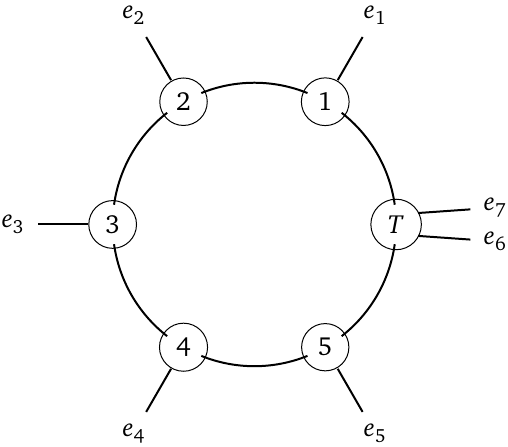
Figure 10: The tensor network in Figure 9 is shown after contracting along the 6 − 7 edge. The tensor which results is labeled T and has rank 4, an increase of one from either of tensors 6 or